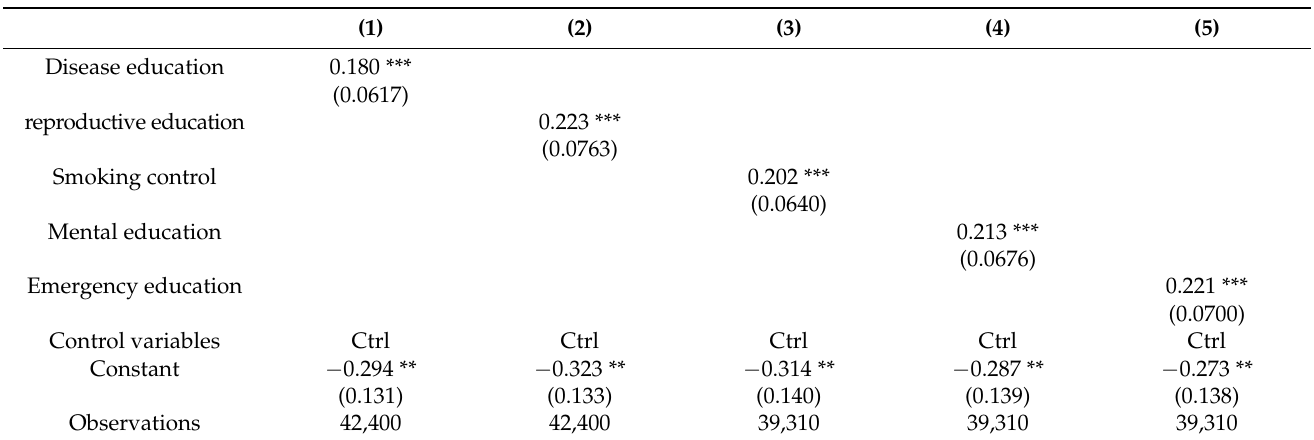
Table 5. Classification based on different types of public health education.